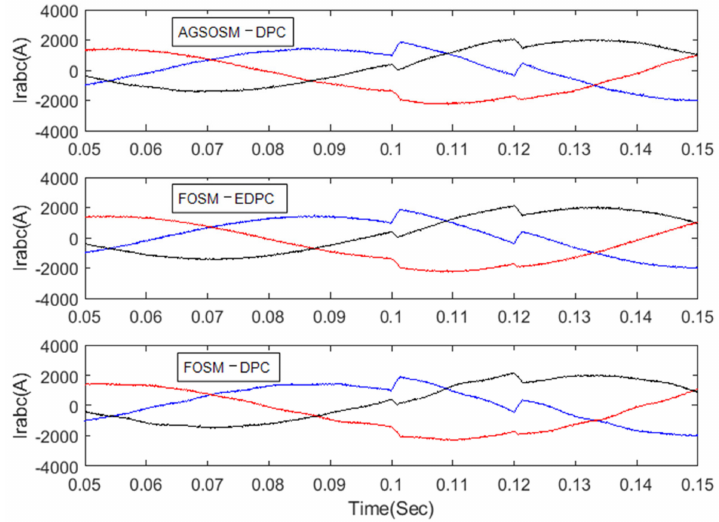
Figure 5. Rotor current under balanced grid voltage.